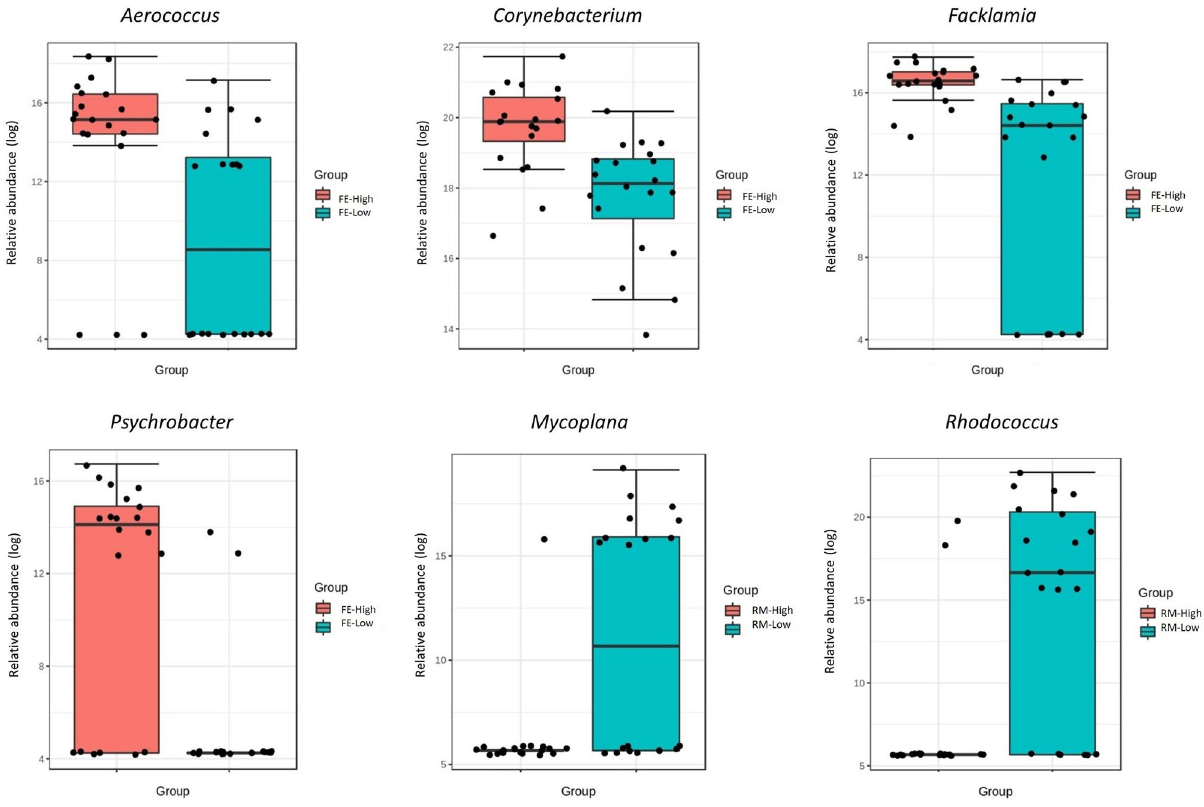
Figure 4. Linear discriminant analysis Effect Size (LEfSe) at genus level between the high and low groups within each trait. An LDA score greater than 2 was used to determine significantly different genera between the groups.